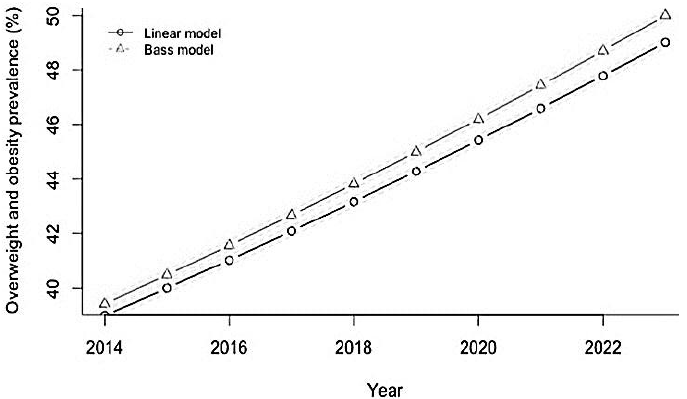
Figure 11. Projected trajectory of overweight and obesity in India, 2013–2023, if SSB consumption continues at the same rate.